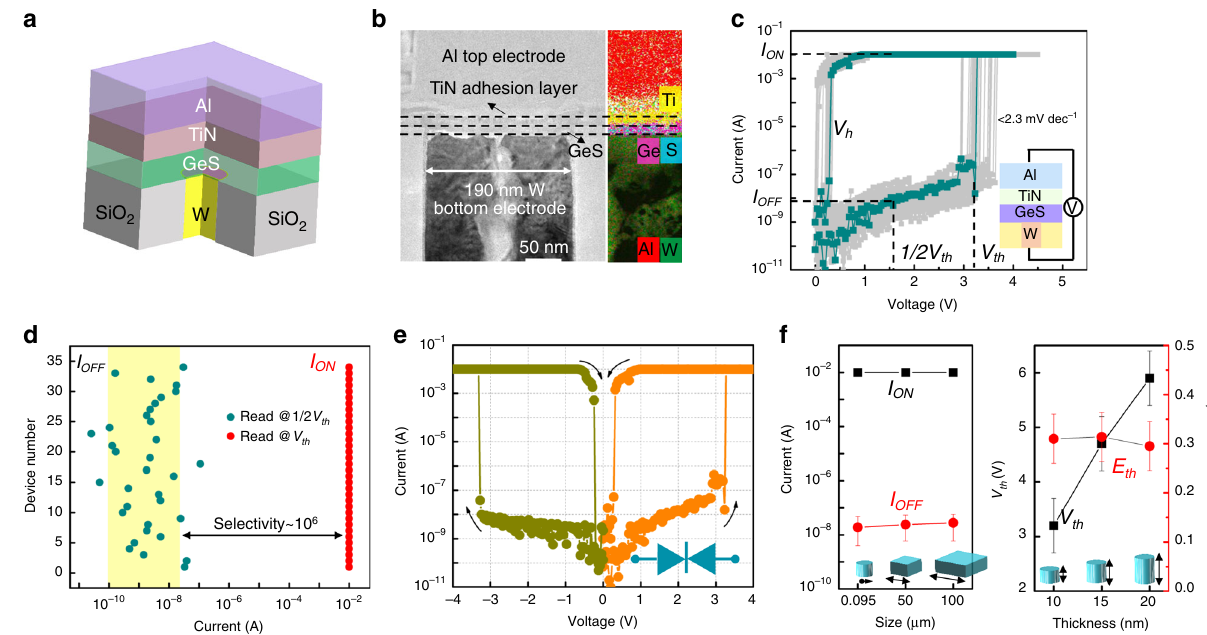
Fig. 1 Structure and electrical characteristics of GeS device. a Schematic structure of an individual cell. b Cross-section TEM image of device displaying the thickness of each layer and corresponding EDS elemental mapping of W, Ge, S, Ti, and Al. The scale bar is 50 nm. c Repeatable DC I – V sweeps with uniform compliance current (10 mA) and low leakage current (10 nA). d Statistical distribution of OFF current and ON current for various fresh cells measured at 1/2 V th and V th , respectively. e Bidirectional threshold switching characteristic of GeS device. The arrows represent the switching directions. f Device performances with different device sizes and GeS thicknesses. ON/OFF current is independent on the size. The V th linearly increases with increasing thickness, while the electric fi eld is almost